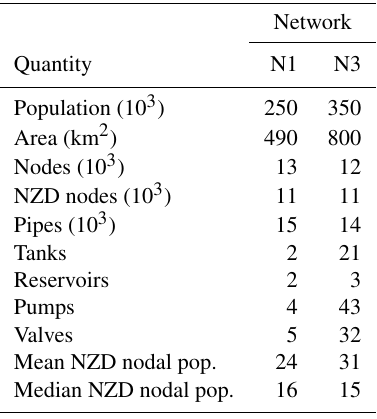
Table 1. Network descriptions. All numbers in this table are rounded independently to two significant figures. NZD: nonzero de- mand.